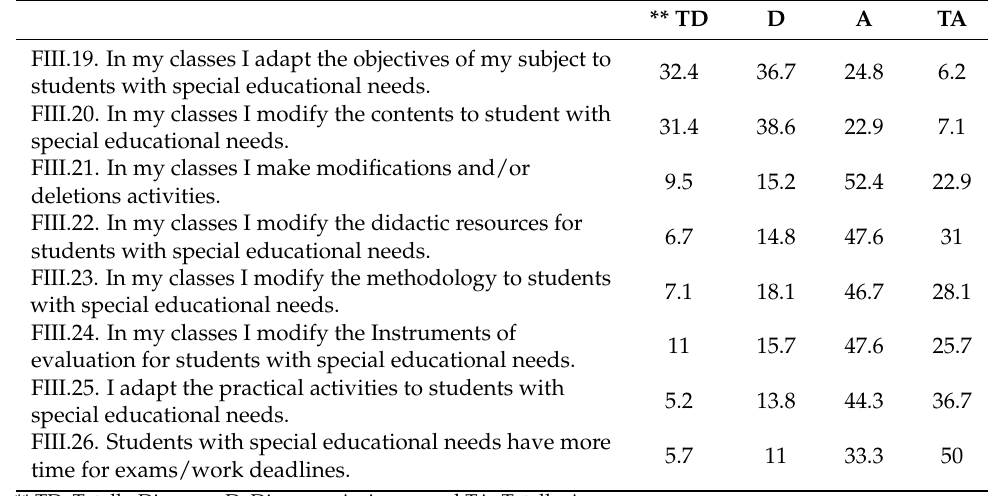
Table 6. Factor III Real implementation of the curricular adjustments (percentage of responses).